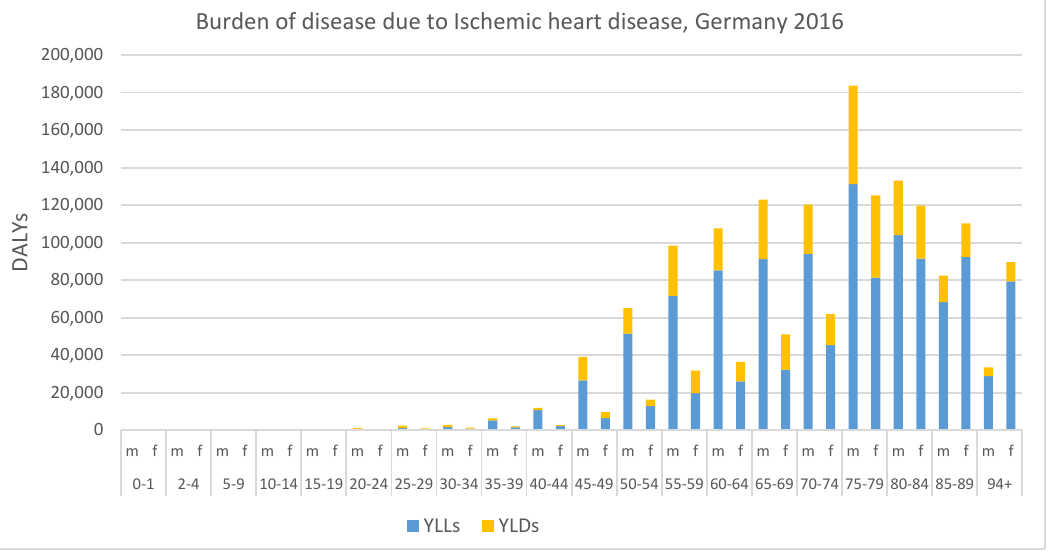
Figure 2. Burden of disease due to ischemic heart disease in Germany 2016, expressed in total YLLs, YLDs and DALYs for males (m) and females (f) by age groups, YLLs = years of life lost due to premature mortality, YLDs = years lived with disability, DALYs = disability-adjusted life years.